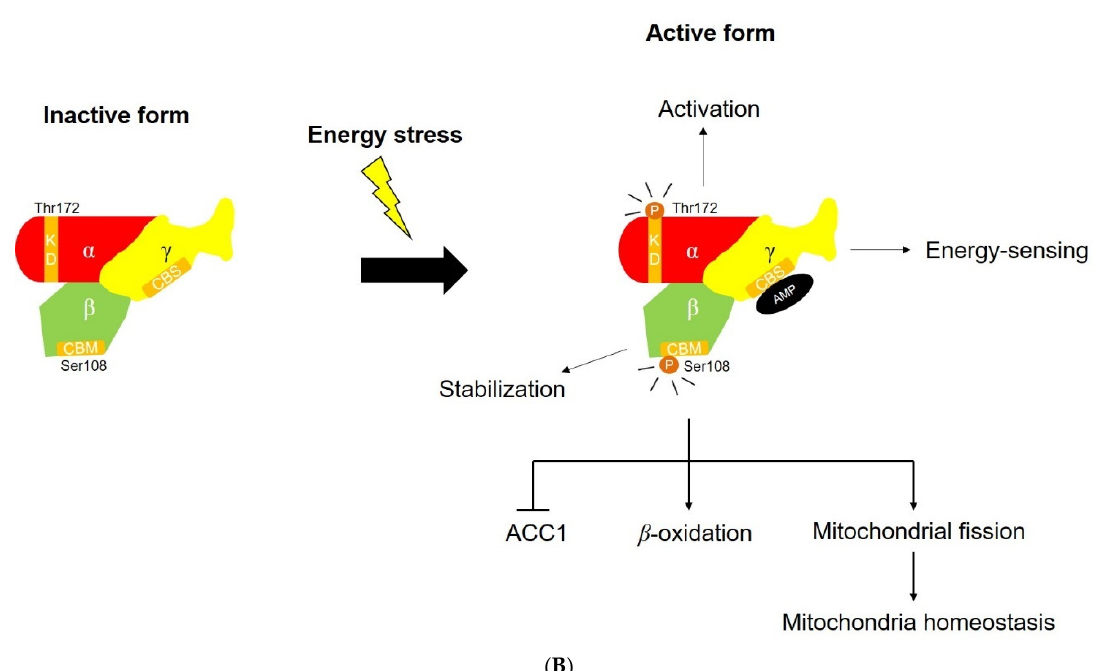
Figure 2. ( A ) Mitochondrial biogenesis modulated by SIRT1, NAD + , and AMPK. Energetic stress (e.g., high NAD + /NADH ratio, increased AMP level) is a good enhancer of mitochondrial biogenesis by activating SIRT1 and PGC1 α . CR elevates NAD + level directly or by activating PM redox enzymes or AMPK indirectly. Rafamycin and resveratrol can enhance AMPK activity. ( B ) The structure of AMPK and the function of AMPK subunits. Each of the subunits plays a different role in AMPK activation. AMPK α subunit activates the AMPK complex, AMPK β subunit stabilises the AMPK complex, and AMPK γ subunit serves as energy-sensor. The activated AMPK complex leads to lipid metabolic change and maintains mitochondrial homeostasis. Abbreviations: ACC, acetyl-CoA carboxylase; AMPK, AMP-activated protein kinase; b5R, cytochrome b5 reductase; CD38, ADP ribosyl cyclase 1; CR, calorie restriction; FOXO, forkhead box transcription factors; MEF2, myocyte-specific enhancer factor 2; mTOR, mammalian target of rapamycin; NQO1, NADH-quinone oxidoreductase 1; NR, nicotinamide riboside; PARP, poly(ADP-ribose) polymerases; PGC1 α , PPAR γ coactivator 1- α ; PPAR, peroxisome proliferator-activated receptor; SIRT, Sirtuin 1.